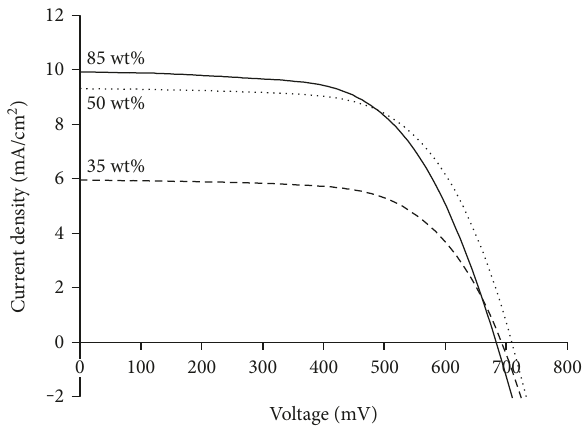
Figure 8: Variation of photocurrent as a function of photovoltage of DSSCs using water-based TiO nano fl uids with 60wt% water 2 and SA-TiO . Concentration of and 40 wt% mixture of BR-TiO 2 2 SA-TiO was 35wt%, 50wt%, and 85 wt%. The solar cells was 2 tested under simulated 1